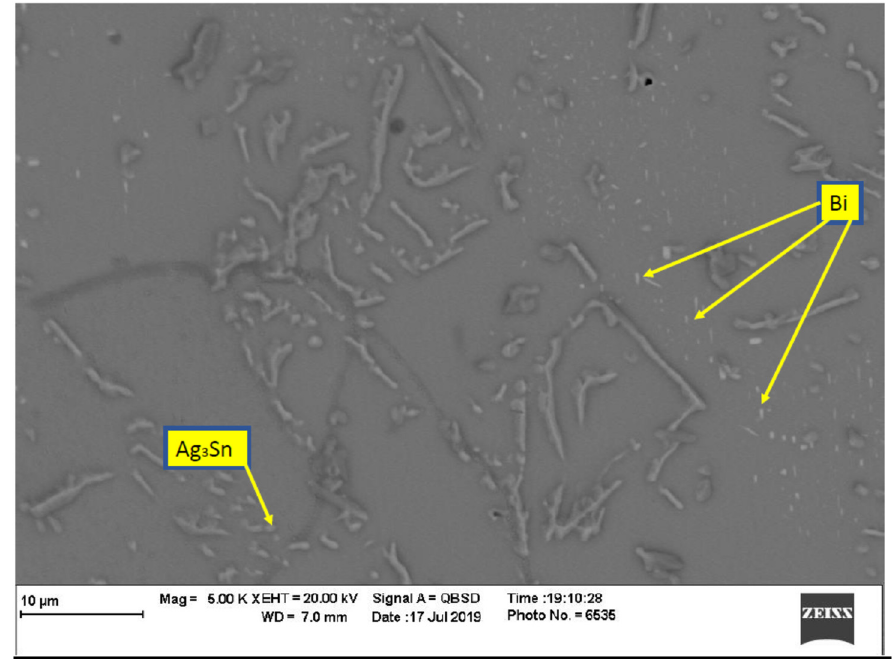
Figure 9. Microstructure of Cyclomax after thermal aging at 150 °C for 1000 h.